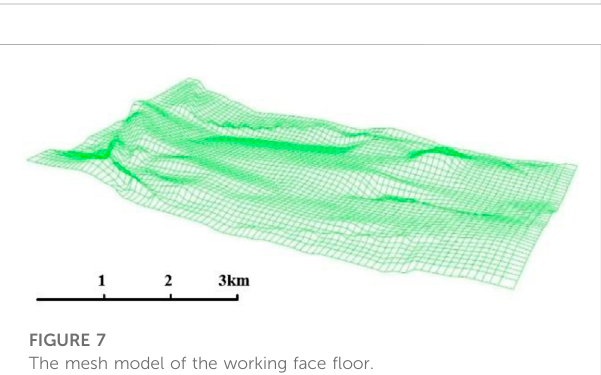
FIGURE 6 Contour lines and drilling information of the working face fl oor.